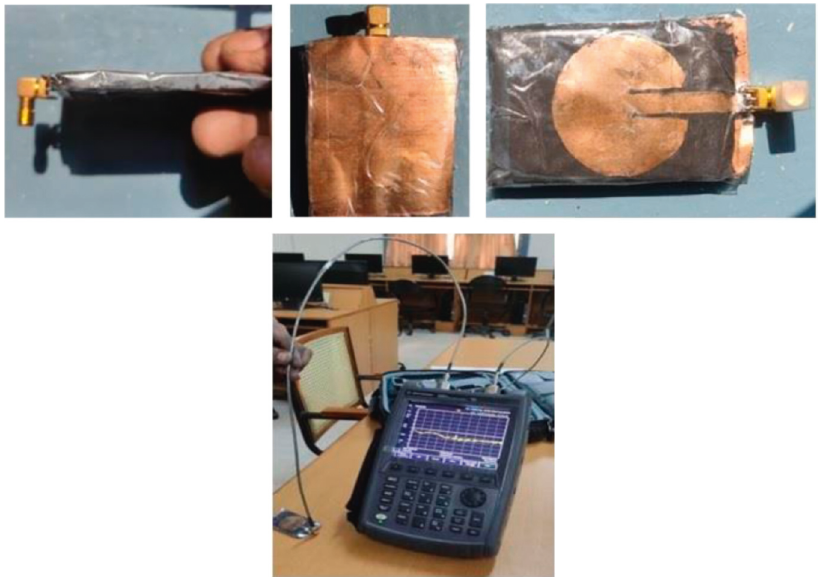
Figure 5: Graphene nanoantenna.